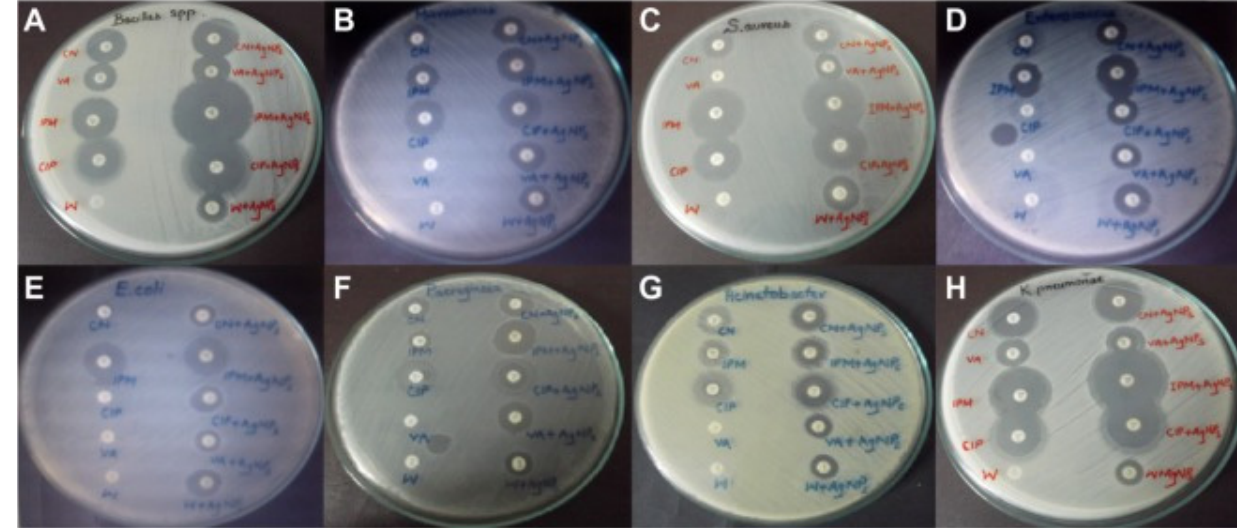
Figure 5. Zones of inhibition of multidrug-resistant bacteria by conventional antibiotics and AgNPs. ( A ) Bacillus ; ( B ) Micrococcus luteus ; ( C ) Staphylococcus aureus ; ( D ) Enterococcus faecalis ; ( E ) E. coli ; ( F ) Pseudomonas aeruginosa ; ( G ) Acinetobacter baumannii ; ( H ) K. pneumoniae . Adapted from [112], Dove Medical Press Ltd., Macclesfield, United Kingdom, 2013.